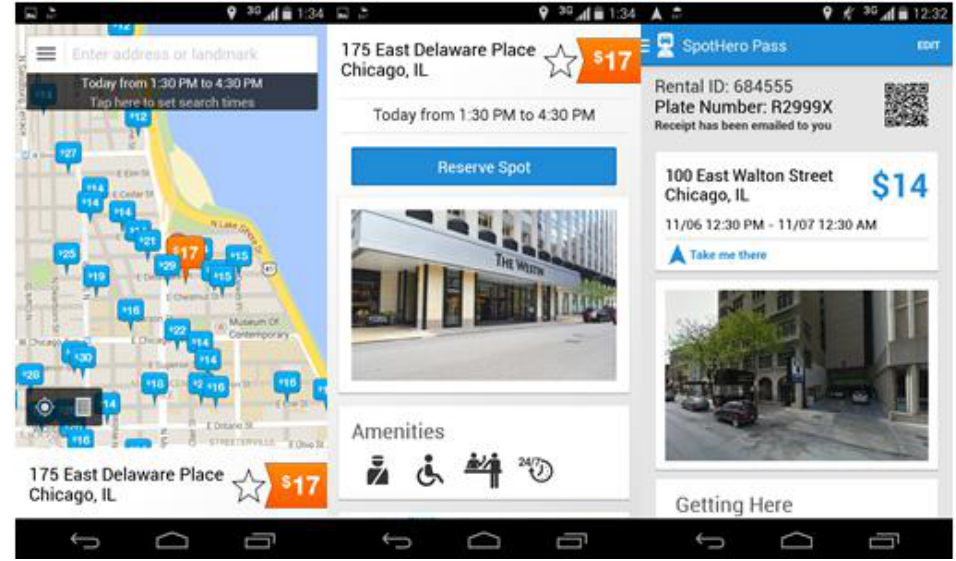
Figure 5. Real-time On-demand Parking Reservation Services: User-friendly Mobile Apps to Review, Select, and Pre-pay for Parking Spots. Image credit: SpotHero